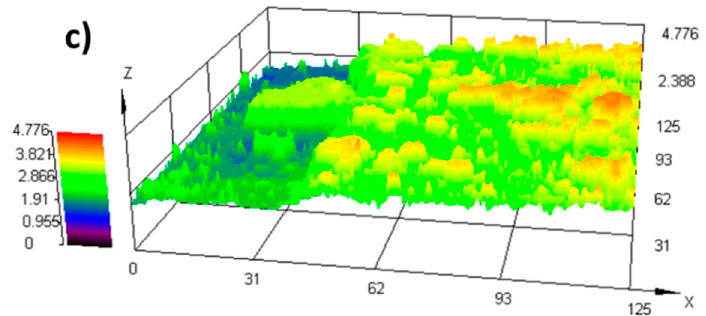
Figure 4. Images of coatings with ( a ) 1 wt.%, ( b ) 2.5 wt.%, and ( c ) 5 wt.% ZrO 2 .